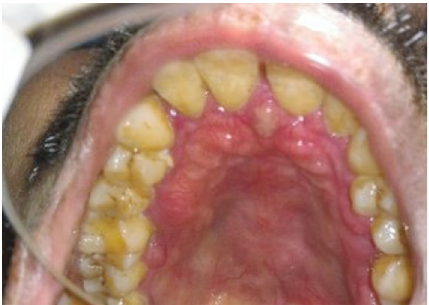
Figure 1: Evidence of di ff use, proliferative soft tissue swelling in the region of the hard palate.